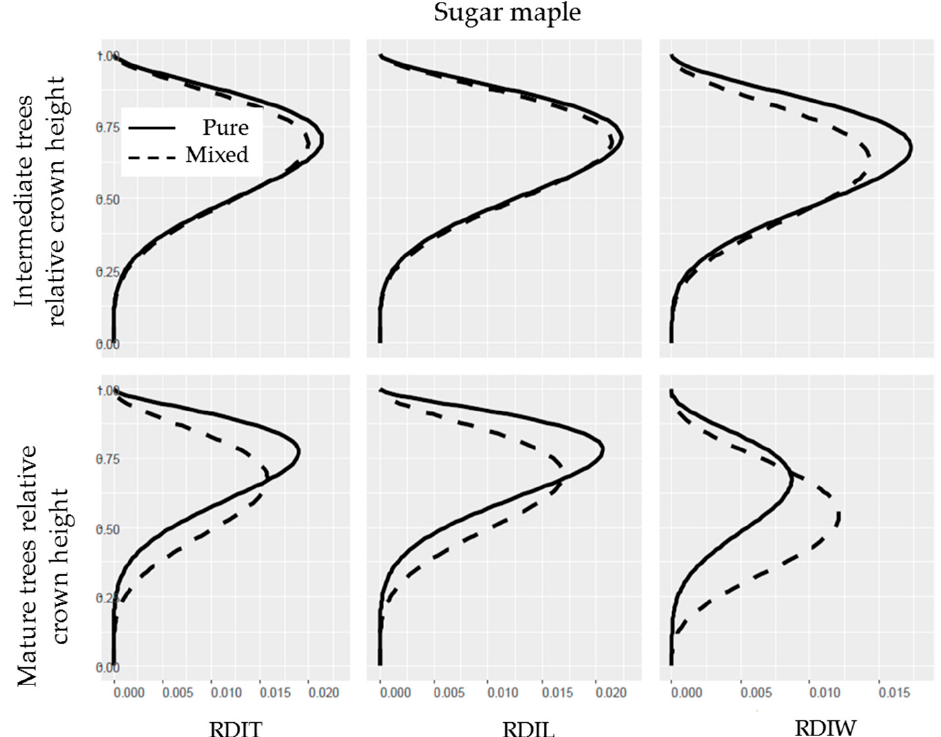
Figure 4. Mean beta distribution of sugar maple. The upper and lower parts show the distributions for intermediate and mature trees, respectively. Plain and dashed lines are respectively for trees in pure and mixed stands. From left to right total: relative density index (RDIT) profile, leaf relative density index (RDIL) profile and wood relative density index (RDIW) profile. On the Y-axis 0 and 1 are respectively the bottom and the top of the crown. A total of 36 sugar maple trees were used (9 per type of stand and developmental stage).